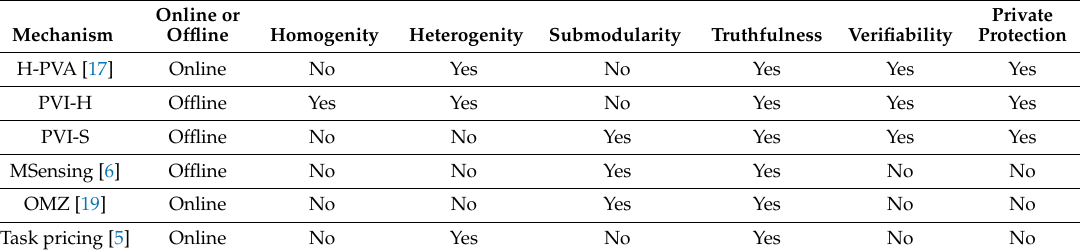
Table 1. Comparison of our work with competitive